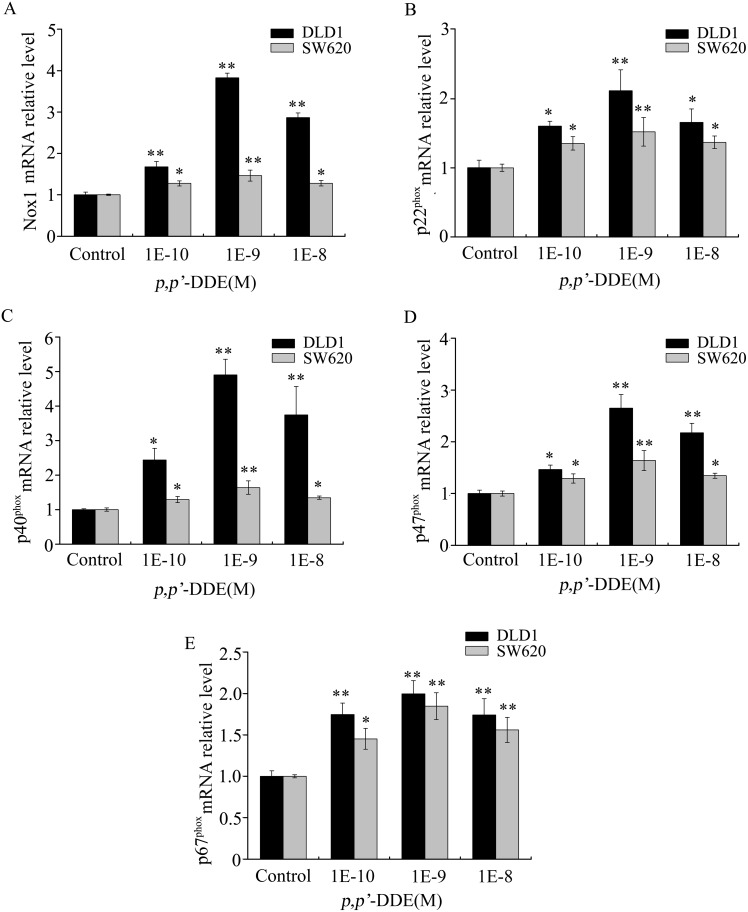
Effects of p,p′-DDE on Nox1, p22phox, p40phox, p47phox and p67phox expression in colorectal adenocarcinoma cells.After DLD1 or SW620 cells were exposed to p,p′-DDE (10−10, 10−9, 10−8 M) for 96 h, the levels of Nox1 (A), p22phox (B), p40phox (C), p47phox (D) and p67phox (E) mRNA expression were determined by quantitative real-time PCR and normalized to control mRNA. The data were acquired from three biologically independent experiments. Values shown were given as the ± SD. *p<0.05 and **p<0.01 compared to control.